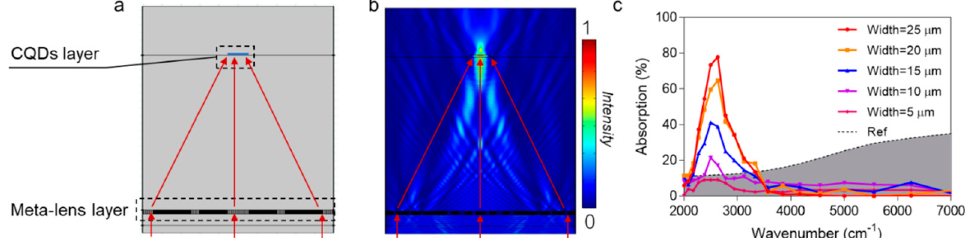
Figure 5. ( a ) Simulation model used to calculate the absorption of CQD detector with meta-lens. ( b ) Simulated light intensity distribution of light passing through meta-lens. ( c ) Simulated absorption of CQD detector with width of 5 to 25 μ m with meta-lens and simulated absorption from a reference detector with a width of 200 μ m (no meta-lens).